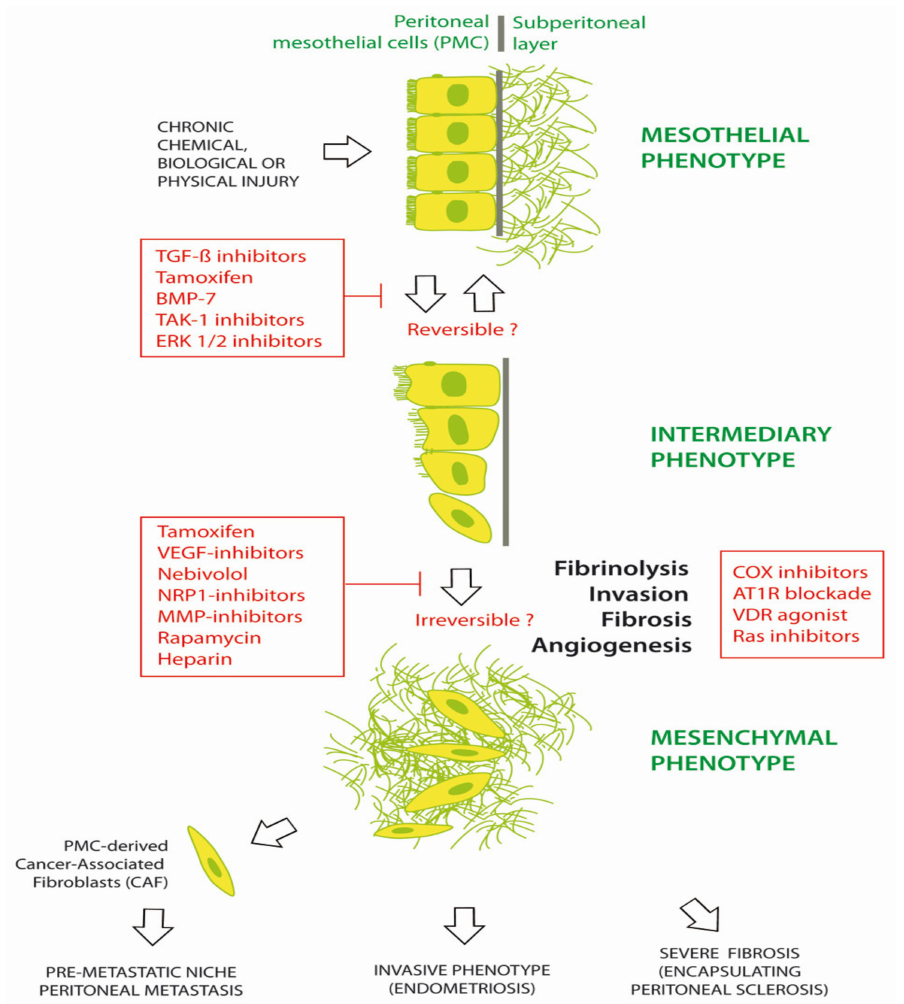
Figure 2. Prevention and treatment of mesothelial to mesenchymal transition